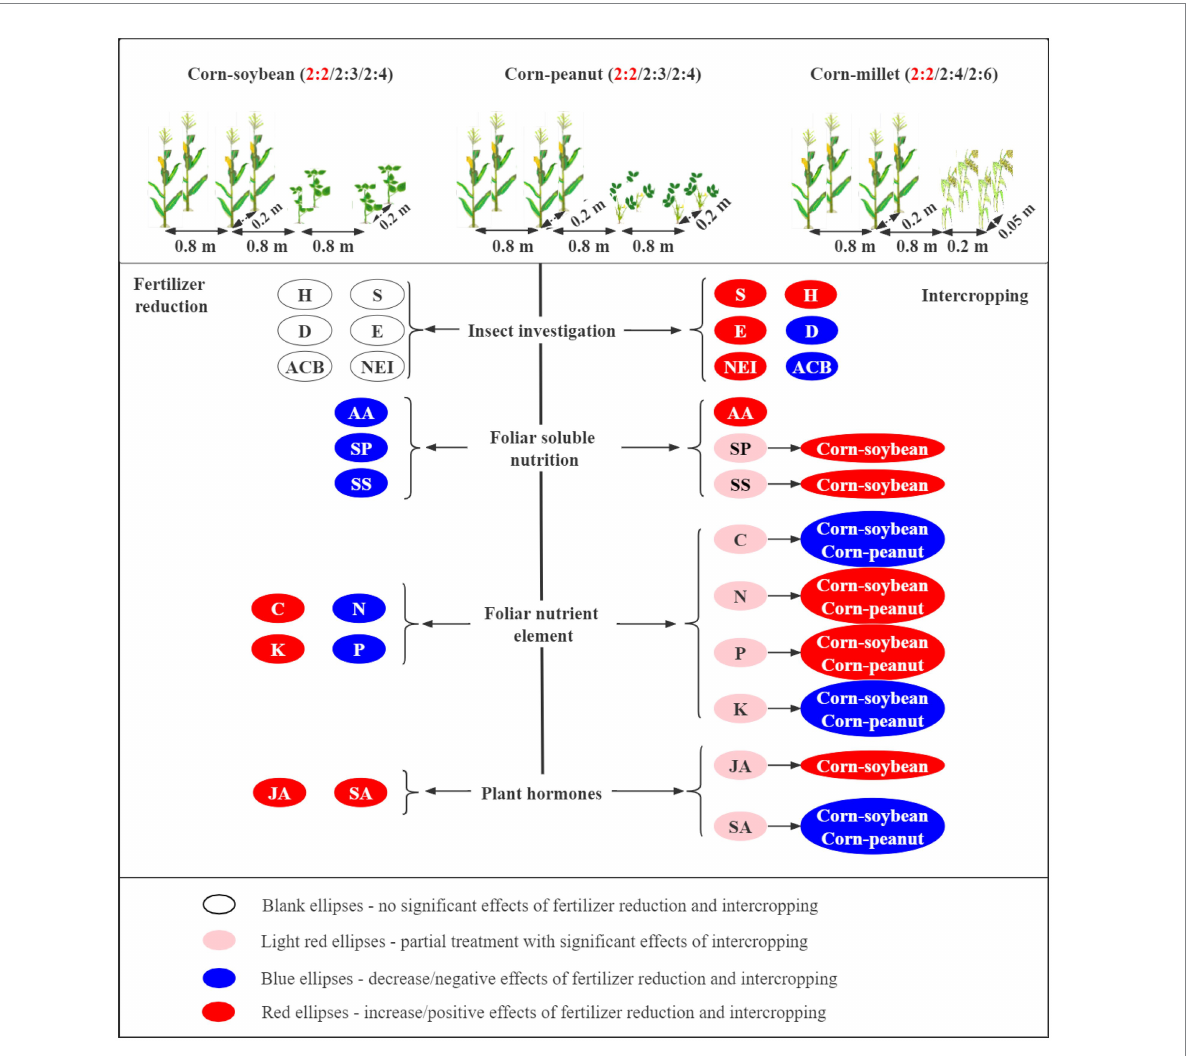
FIGURE 8 Patterns of intercropping type and fertilizer levels affecting corn nutrients and insect communities ( S -Species number; H -Shannon-Wiener diversity index; E -Pielou evenness index; D -Simpson dominance index. ACB: number of Asian corn borers; NEI: number of natural enemy insect species; AA: amino acid; SP: soluble protein; SS: soluble sugar; C, N, P and K: total carbon, total nitrogen, total phosphorus and total potassium in corn leaves; JA: jasmonic acid; SA: salicylic acid; → : represents a range from large to small). The effects of fertilizer reduction and intercropping type on corn nutrition and insect communities are shown on the lower left and lower right of the figure,